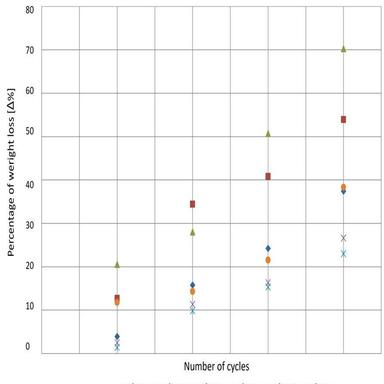
Percentage of weight loss of compounds during the various cycles.